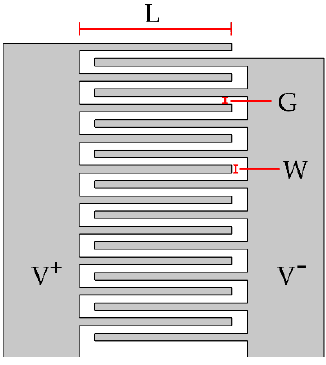
Sensor Coding Comb Spacing (µm)